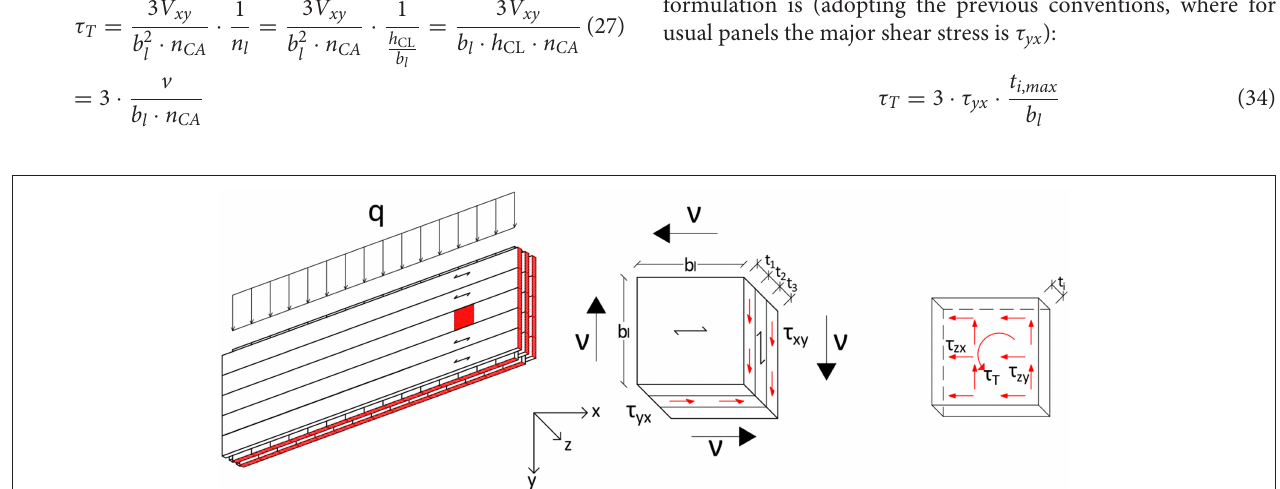
Frontiers in Built Environment |